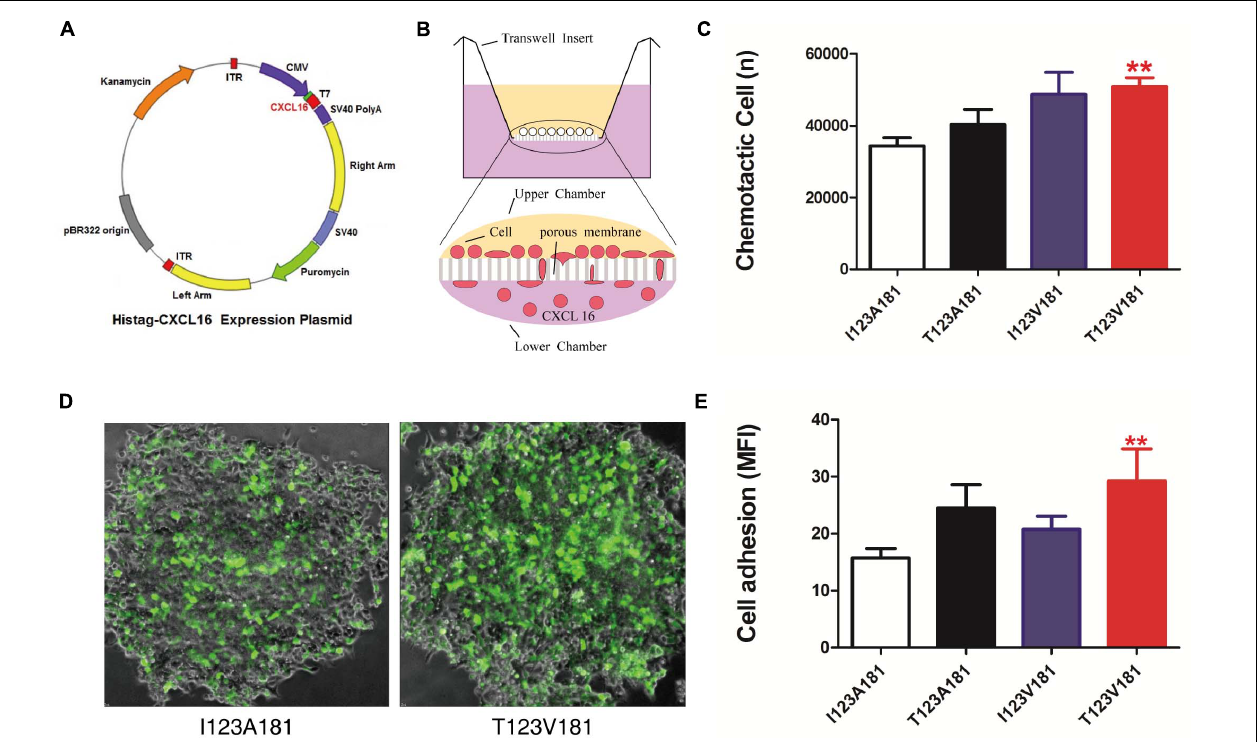
FIGURE 2 | T123V181 haplotype enhances the chemotaxis and adhesion of inflammatory cells. (A) Map of the CXCL16 expression plasmid. (B) Schematic diagram of the chemotactic assay. The percentage of THP-1 cells recruited to the lower chamber was calculated to represent chemotaxis. (C) The chemotaxis of the CXCL16-T123V181 protein was significantly higher than that of the other three proteins (** P < 0.01). (D) The percentage of THP-1 cells with green fluorescence expressing transmembrane forms of CXCL16-T123V181 protein attached to RAW264.7 cells was calculated to represent the adhesion ability. (E) The adhesion ability of cells expressing CXCL16-T123V181 protein was significantly higher than that of the other three proteins (** P <